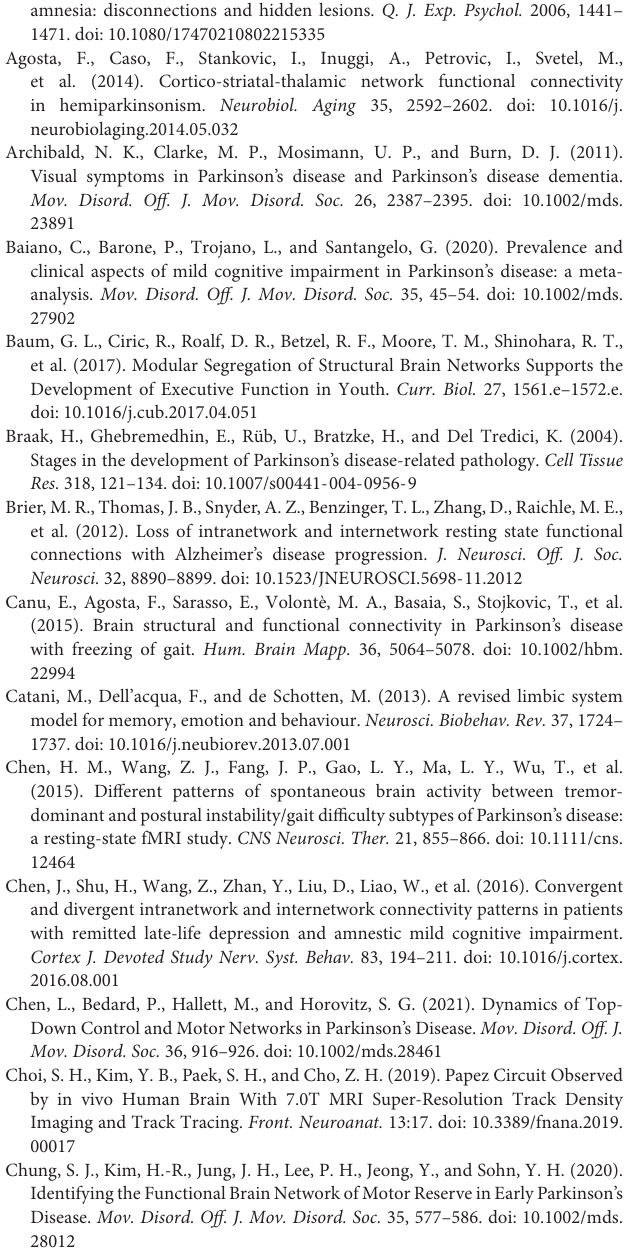
Supplementary Figure 2 | Results of functional connectivity analyses at 3 levels with global signal regression. (A) Statistical analysis indicates significant between-group differences regarding the total functional connectivity at the 7 nodes ( P < 0.05, FDR corrected). (B) The colorful circle indicates the composite of 9 RSNs. The 4 red triangles indicate that the RSNs showed altered intra-network connections based on results indicating statistical significance. The histogram compares the 4 networks between PD and HC groups; the y-axis represents intra-network functional connectivity strength. (C) The colorful circle indicates the composite of 9 RSNs. The line linking 2 RSNs indicates altered individual inter-network connections based on statistically significant results. The